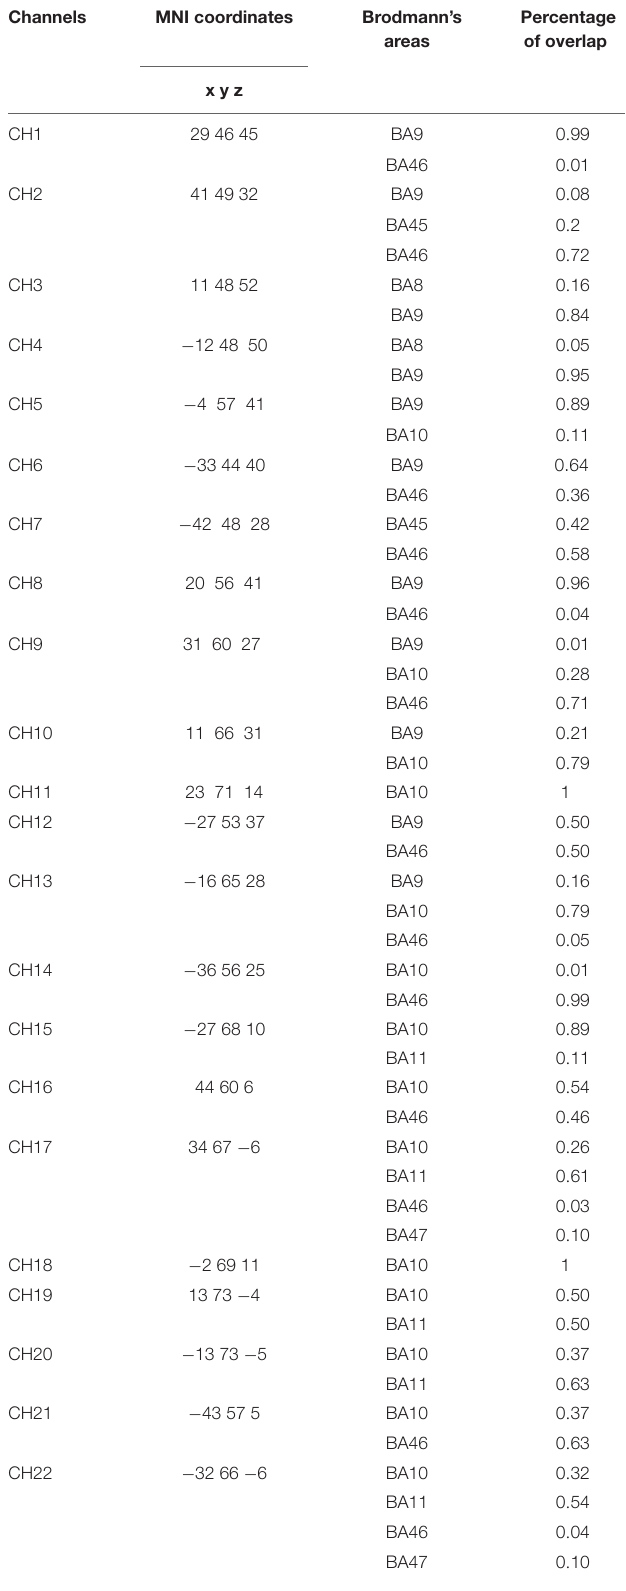
TABLE 1 | The MNI coordinates and the percentage of Brodmann areas covered by each projected channel. Channels MNI